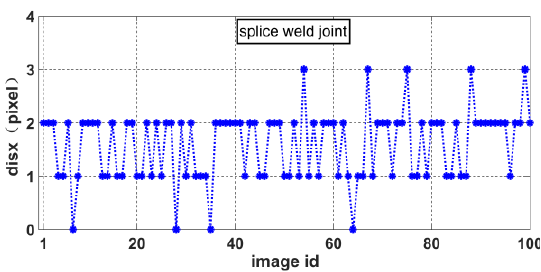
Figure 14. Distribution of dis x for splice weld joints.